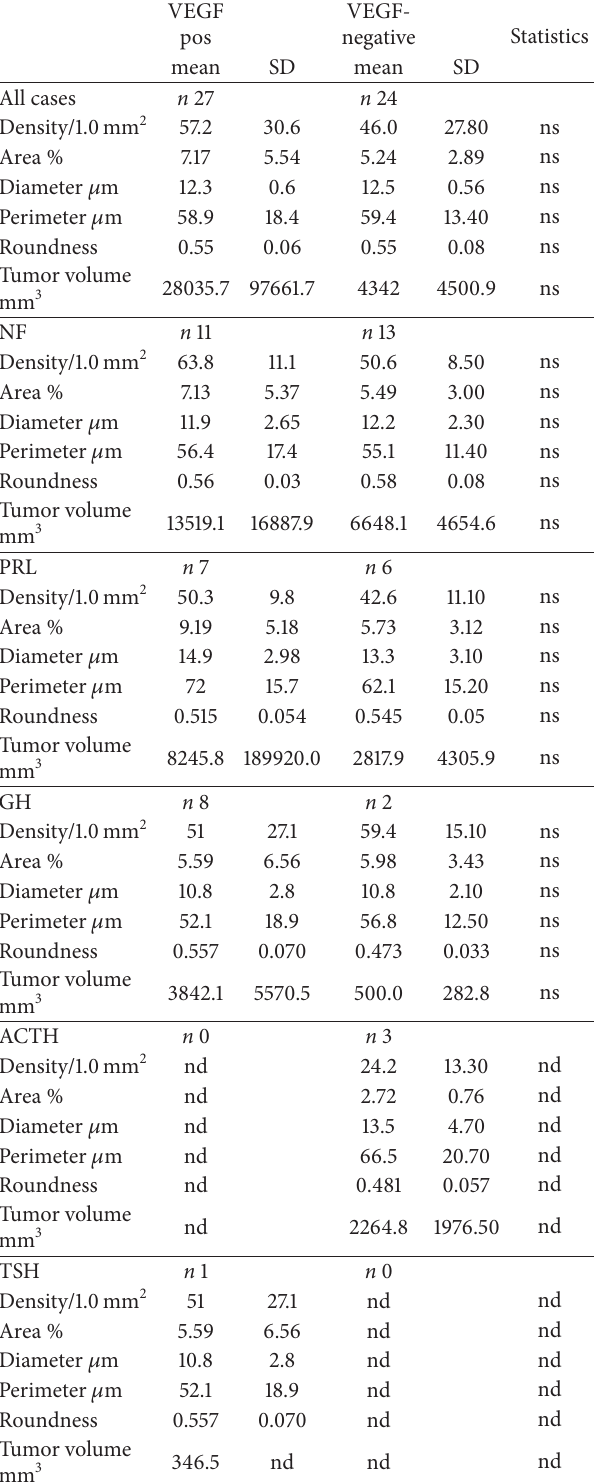
Figure 3. Vessel diameter was significantly larger in PRL- secreting adenomas than GH-secreting adenomas (Figure